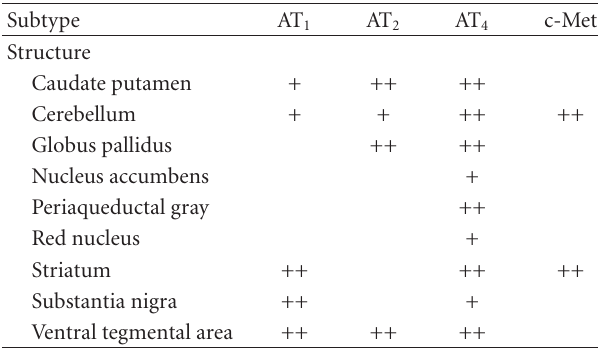
Table 1: Predominant distributions of the three angiotensin recep- tor subtypes and the HGF/c-Met receptor identified in mammalian brains.